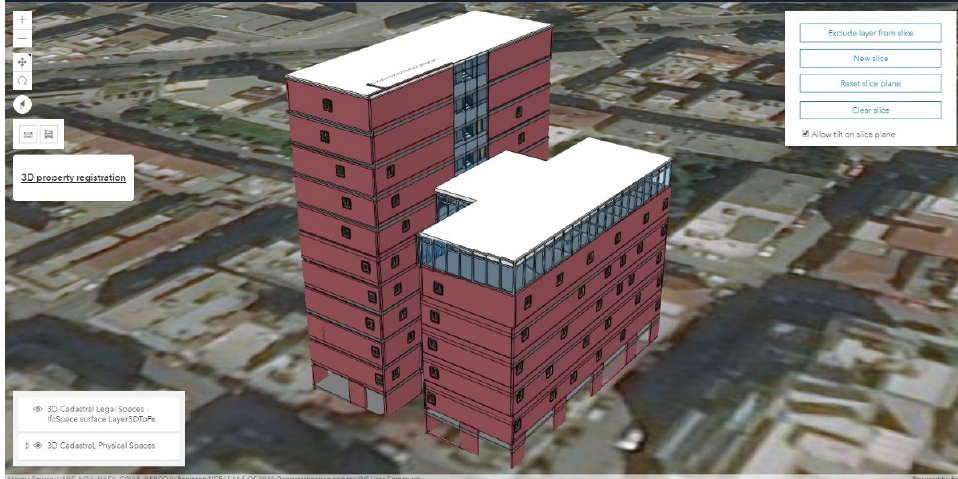
Figure 2. Overview of the user interface of the developed web application.